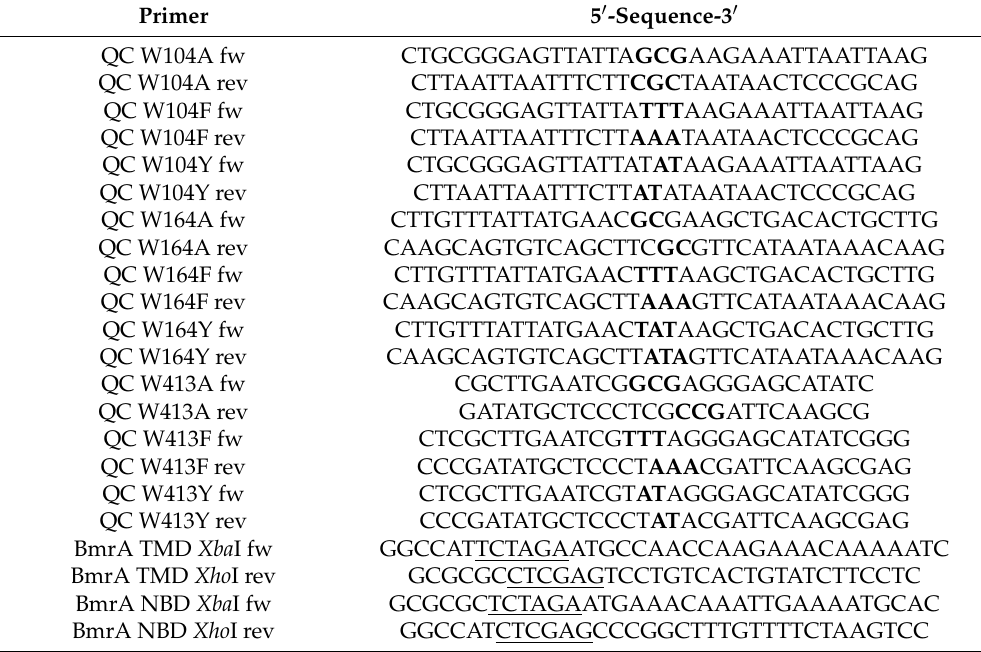
Table 1. The oligonucleotide sequences (5 (cid:48) → 3 (cid:48) ) used in this study. Highlighted in bold are the changed bases. The underlined bases are recognized by a restriction enzyme. Forward primers were abbreviated as fw and reversed primers as rev. Primer 5 (cid:48) -Sequence-3 (cid:48) QC W104A